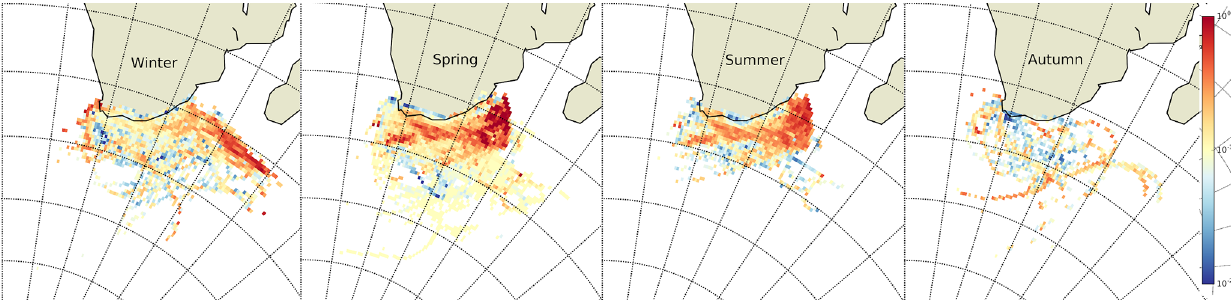
Figure 8. Seasonal breakdown of 90th percentile highest Hg concentrations from the Eastern Ocean source region. Highest Hg concentrations are mostly associated with austral spring and summer, which supports primary production as a potential source for oceanic Hg releases. Table 2. Annual median GEM